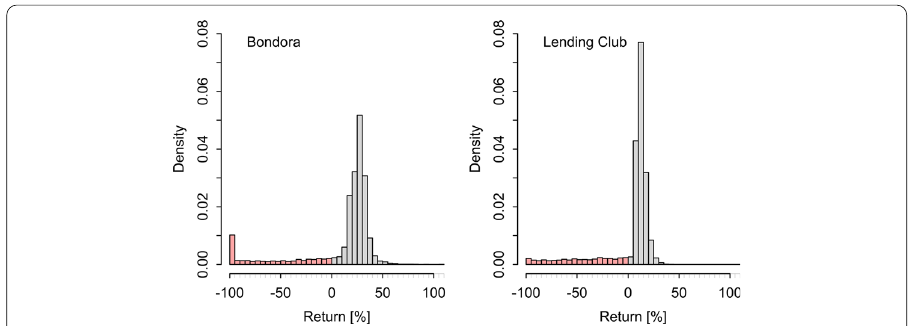
Fig. 2 Distribution of loan returns. Notes : Red color denotes loans that led to negative internal rate of return